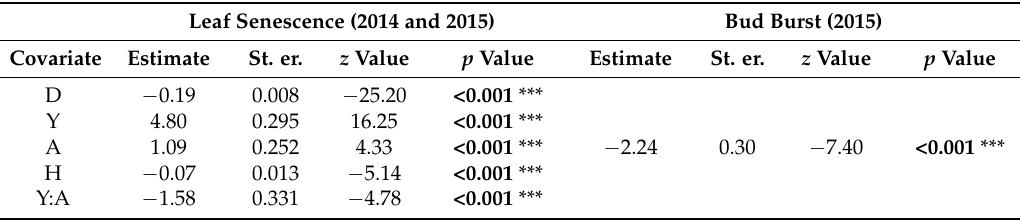
Table 3. Model statistics for the general linear mixed models of the ordinal phenological response variables leaf senescence and bud burst.